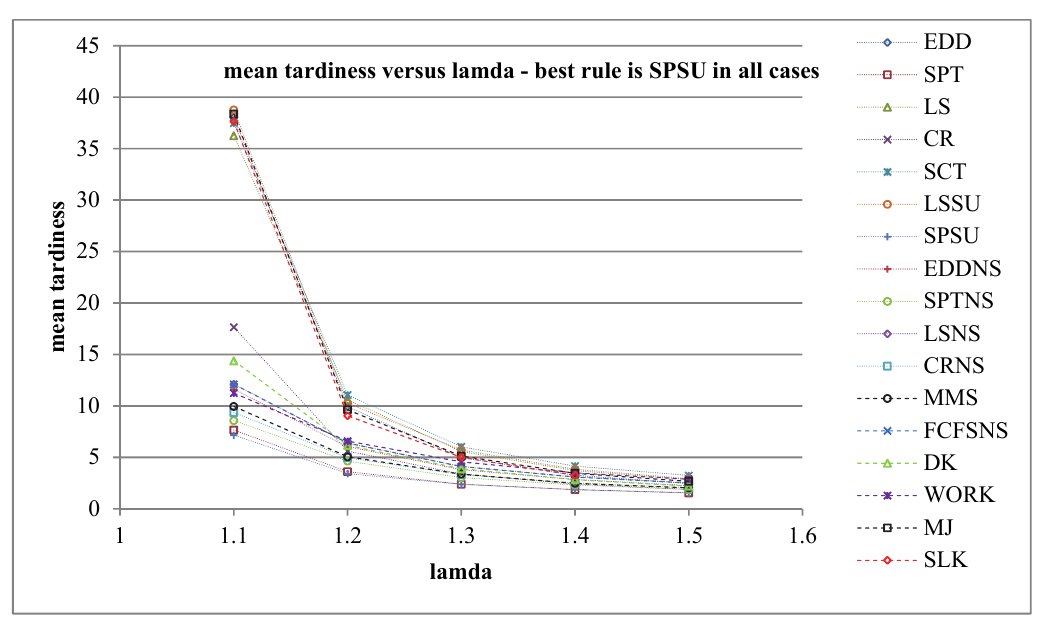
mean tardiness versus lamda - best rule is SPSU in all